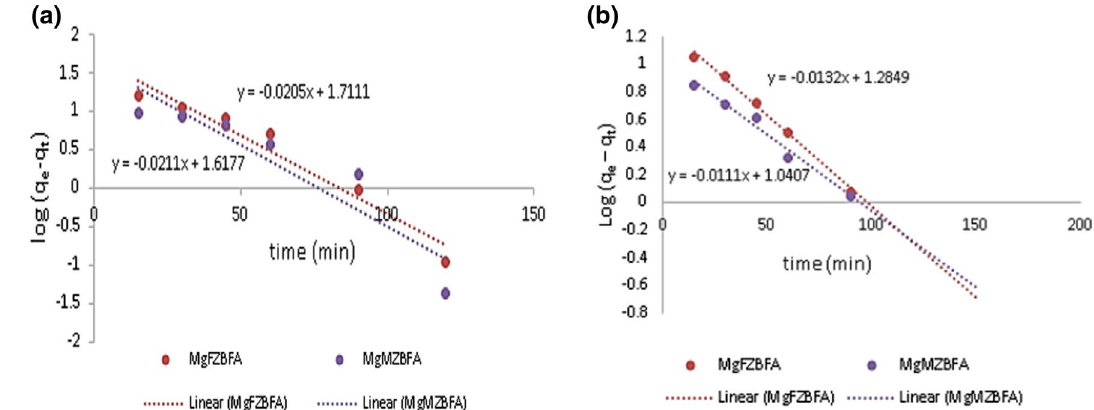
Fig. 16 Pseudo-first-order kinetic model plots for the sorption of a PNAN, b NB on MgFZBFA and MgMZBFA